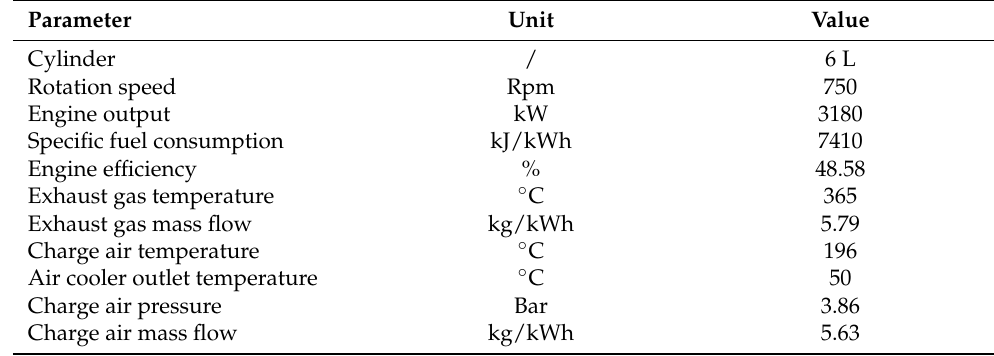
Table 1. The selected marine dual fuel engine’s main parameters of its gas fuel